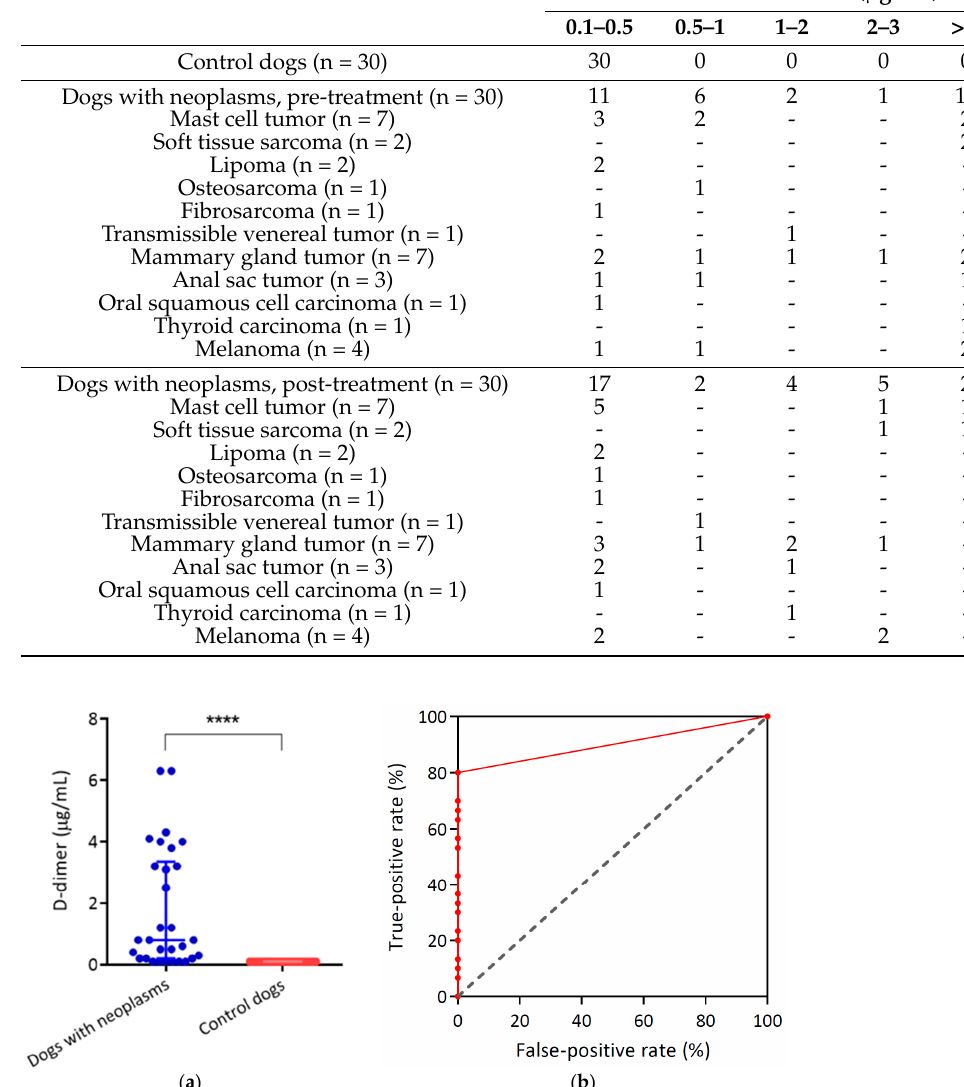
Figure 1. D-dimer concentrations in plasma of all dogs with neoplasms (n = 30) and control dogs (n = 30). ( a ) The median values of D-dimer in cancer and control dogs were 0.8 ± 3.15 and 0.1 ± 0.0 µg/mL, respectively ( p < 0.0001); ( b ) The ROC curve of detection of D-dimer. The area under the ROC curve (AUC) is 0.90 under a 95% confidence interval of 0.8116–0.9884, with significant difference ( p < 0.0001). ****, p < 0.0001.